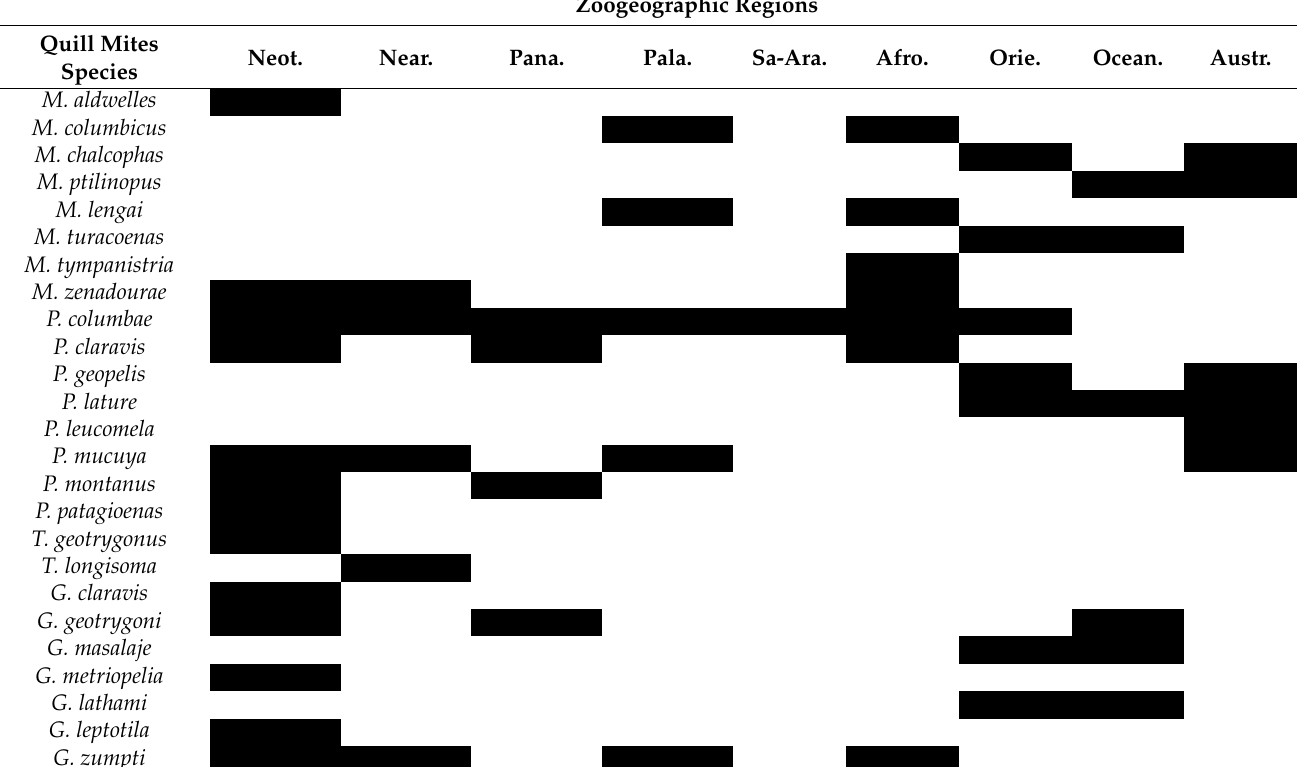
Table 6. Distribution of syringophilid associated with birds from order Columbiformes in zoogeographical regions. Zoogeographic Regions Quill Mites Neot. Near. Pana. Pala. Sa-Ara. Afro. Orie. Ocean. Austr. Species